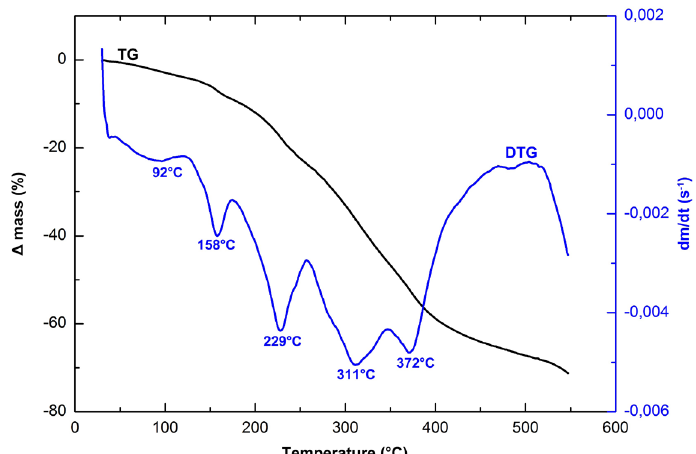
FIGURE 1 – TG and DTG curves of the bilberry leaf powder extract with the indication of peak temperatures of mass loss events.